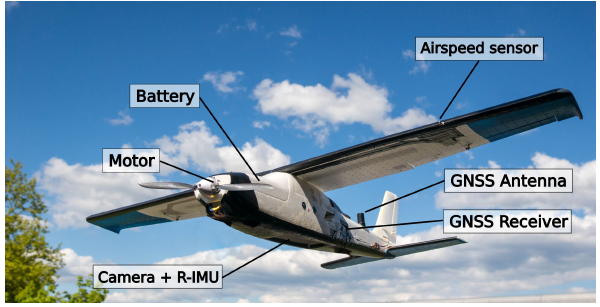
Figure 1. Fixed-wing